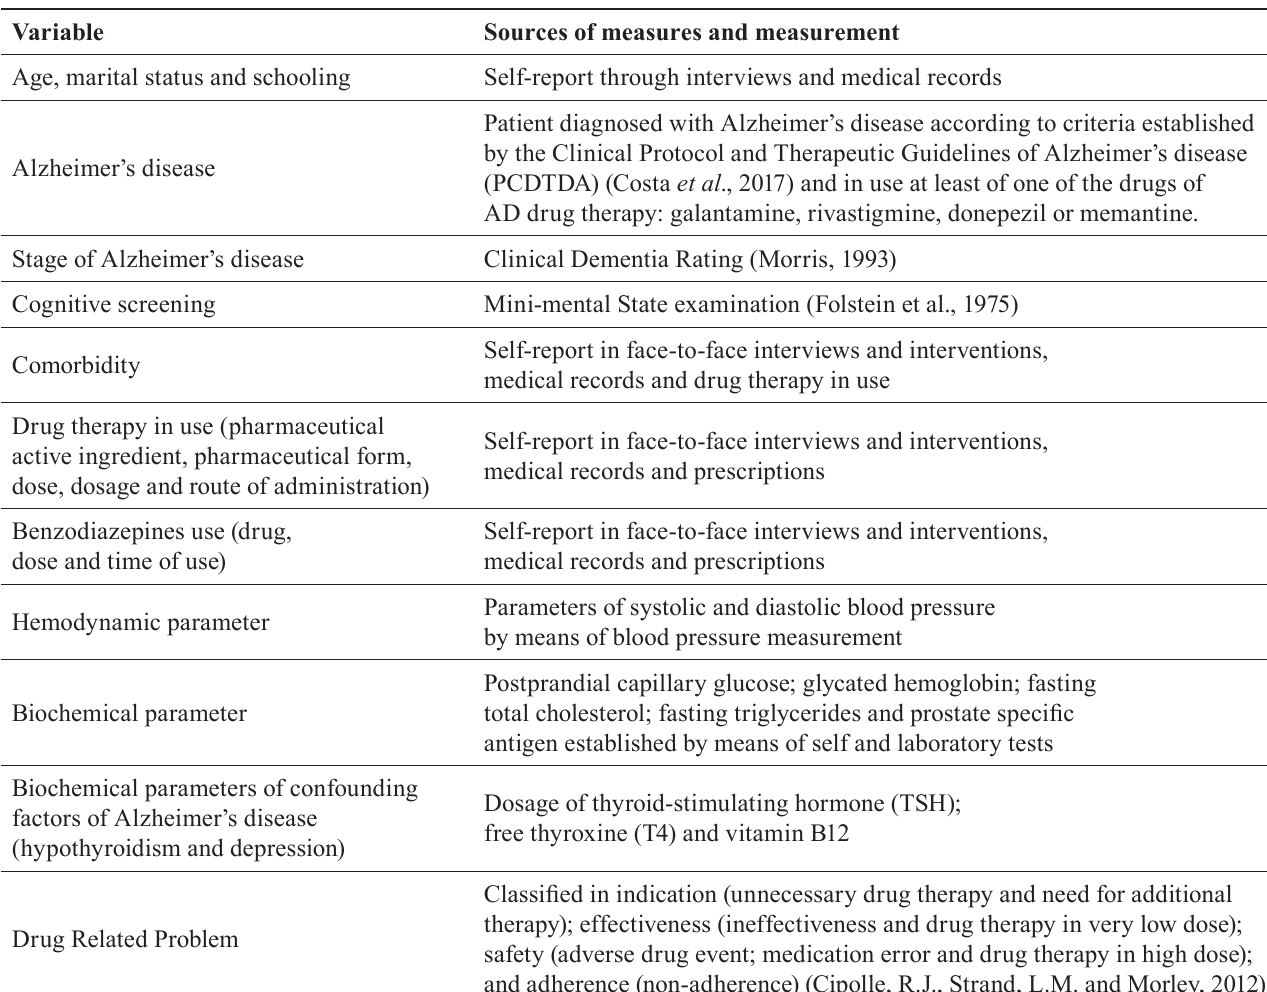
TABLE I - V ariables of interest and sources of measures and measurement